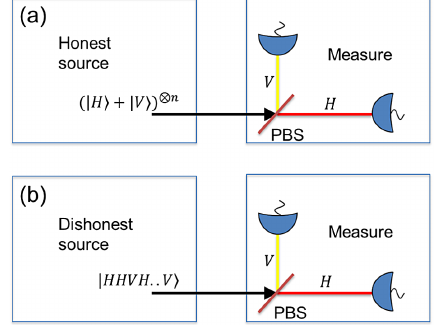
FIG. 1. Illustration of a generic QRNG setup in which we take photon polarization as the example. H and V refer to horizontal and vertical polarizations, respectively. PBS refers to a polarizing beam splitter. (a) The source functions normally (trusted) and sends superpositions of H and V polarizations, which offer quantum randomness. (b) The source malfunctions (untrusted) and sends H and V polarizations in a predetermined order, which should output no genuine randomness. From the measurement result viewpoint, one cannot distinguish these two